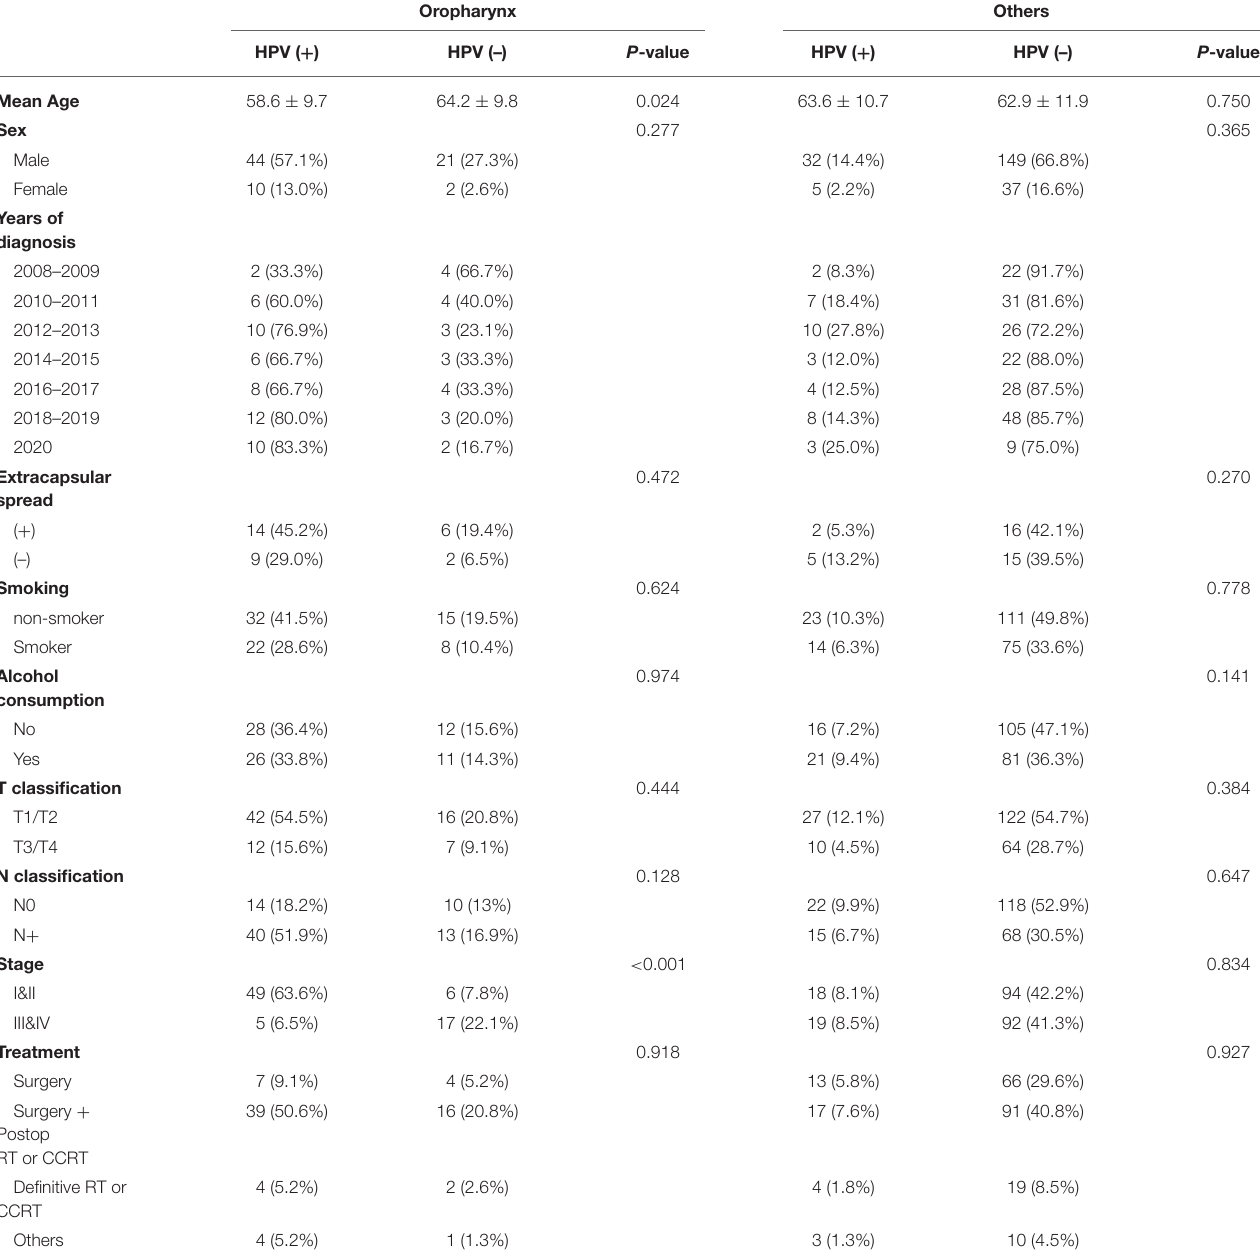
TABLE 2 | Comparisons of head and neck squamous cell carcinoma according to HPV status. Oropharynx